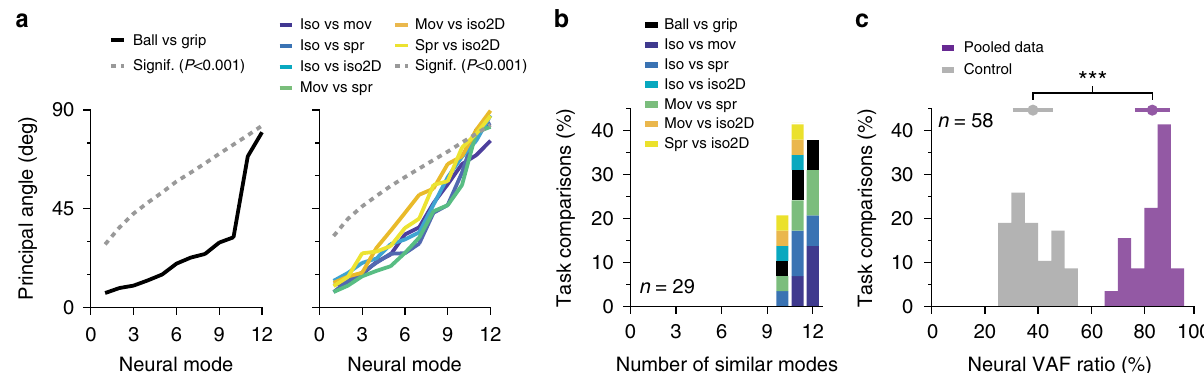
Fig. 3 Comparison between neural manifolds for two different tasks. a Principal angles for one session of reaching and grasping tasks from Monkey T (left) and for one session of wrist tasks from Monkey J (right). Each pairwise comparison is shown as one colored trace (see legend). Leading principal angles were far below the P < 0.001 signi fi cance level (dashed gray line), indicating signi fi cant similarities in the structure of the neural modes across tasks. For simplicity, only the most stringent signi fi cance threshold is shown for all pairwise comparisons across wrist tasks (right panel). b Number of neural modes for which all principal angles were signi fi cantly small across all monkeys, sessions, and task pairs ( P < 0.001; surrogate threshold obtained with the tensor maximum entropy method). c Ratio of the variance accounted for (VAF) when projecting the neural data from one task onto the neural manifold from another task, to the VAF when projecting the same data onto its corresponding manifold (purple); data pooled over all monkeys, sessions, and task pairs. We compared this distribution to a control based on the 99.9th percentile of the distribution of VAF ratios when projecting neural data onto randomly generated manifolds (gray); the *** denote P ~0 (two-sided Wilcoxon rank sum